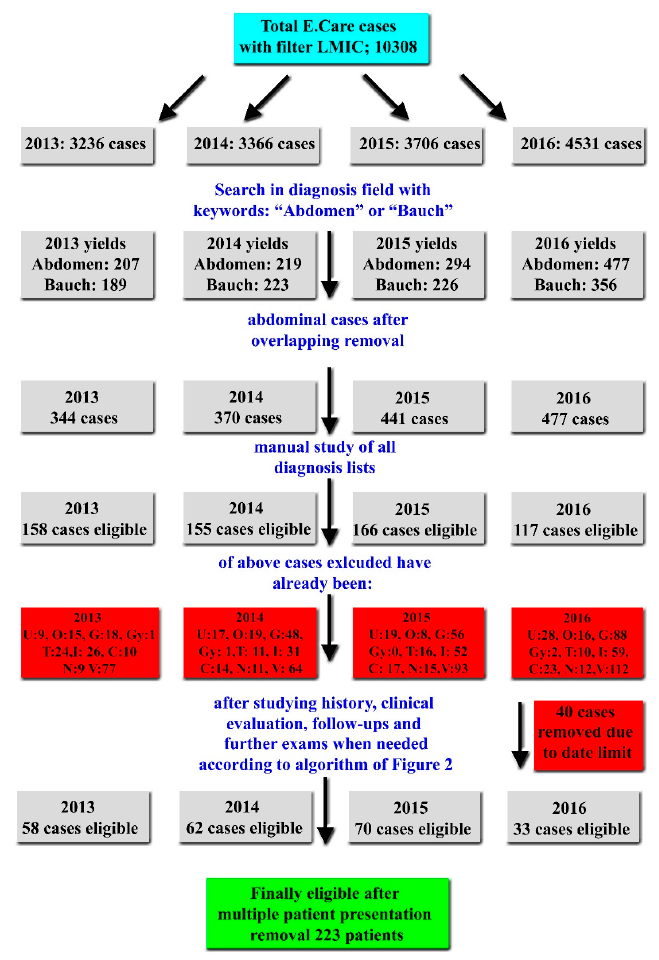
Figure 1. Flow chart of the search procedure for the identification of eligible patients. C; cardiological cases, G; gastrointestinal cases, Gy; gynecological cases; I; infectious cases, LMIC; low- and middle-income countries, N; neurological cases; U; urological / renal cases, Trauma cases, V; various cases (such as; body packer, intoxications (including alcohol), suicide attempt, rheumatological, ORL, unclear thoracic pain-dyspnea, orthopedic without trauma, thrombosis etc.).